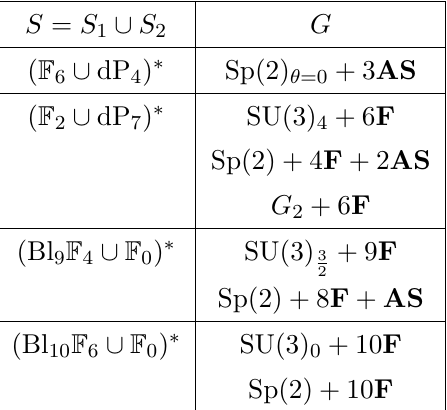
) (cid:3) are not (cid:1)